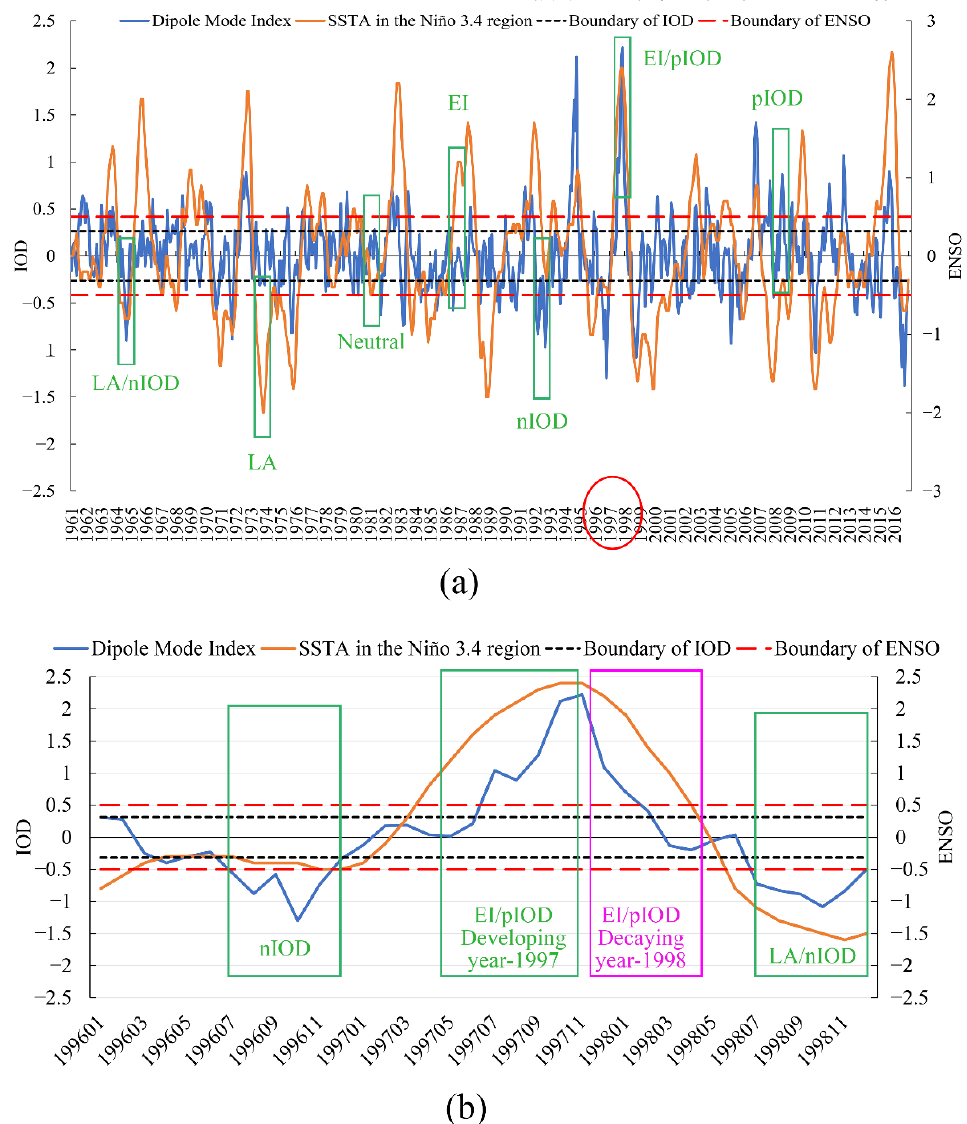
Figure 3. ( a ) Diagram of scenarios for the whole series; ( b ) Diagram of scenarios of the typical period from 1996 to 1998, which is highlight by the red circle in ( a ) .